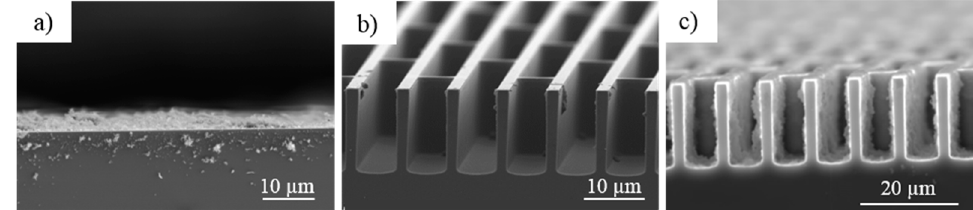
Figure 4. ( a ) SEM image after deposition of 2D SiNPs (NMP) electrode; ( b ) SEM image of trench structures with an aspect ratio of 3 after DRIE etching and cleaning; ( c ) SEM image of trench structures with an aspect ratio of 3 after SiNPs